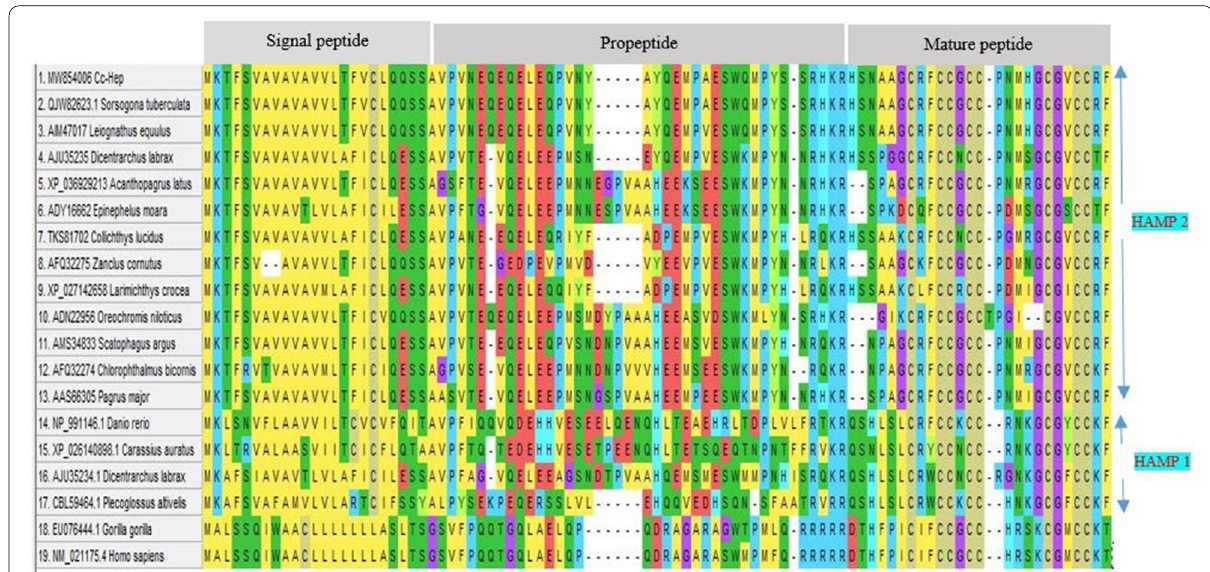
Fig. 4 Multiple sequence alignment of Cc -Hep using MEGA 6 software. Signal peptide, propeptide and mature peptide of all the sequences are highlighted